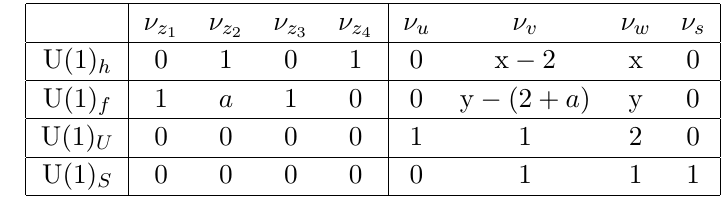
(cid:12)bration over F a . 112